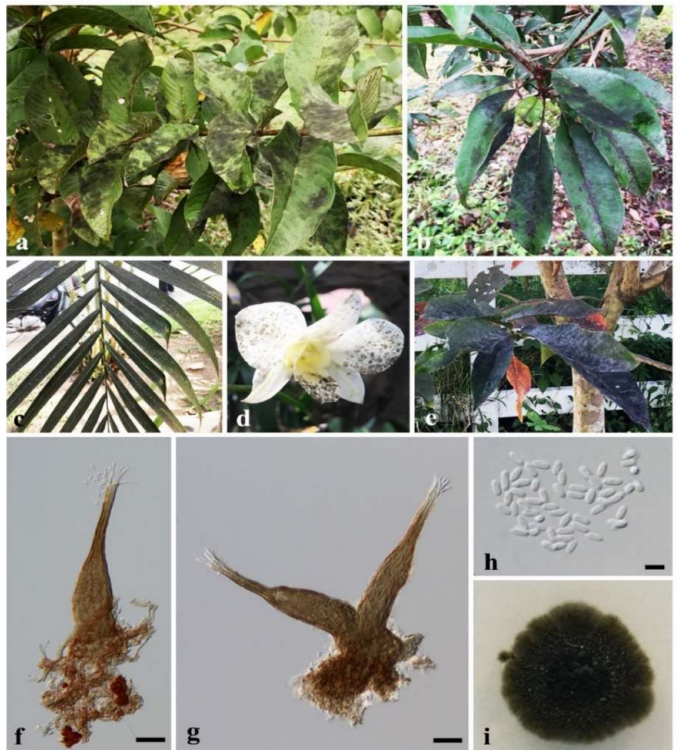
Figure 3. Capnodium spp. ( a – e ) host plants: ( a ) Psidium guajava (CRC 114), ( b ) Manilkara zapota (CRC 117), ( c ) Dypsis lutescens (CRC 119), ( d ) Dendrobium hybrid (CRC 120), ( e ) Lagerstroemia speciose (CRC 121); ( f , g ) pycnidia, ( h ) conidia, ( i ) colony on PDA. Scale bars: ( f , g ) = 50 µ m; ( h ) = 10 µ